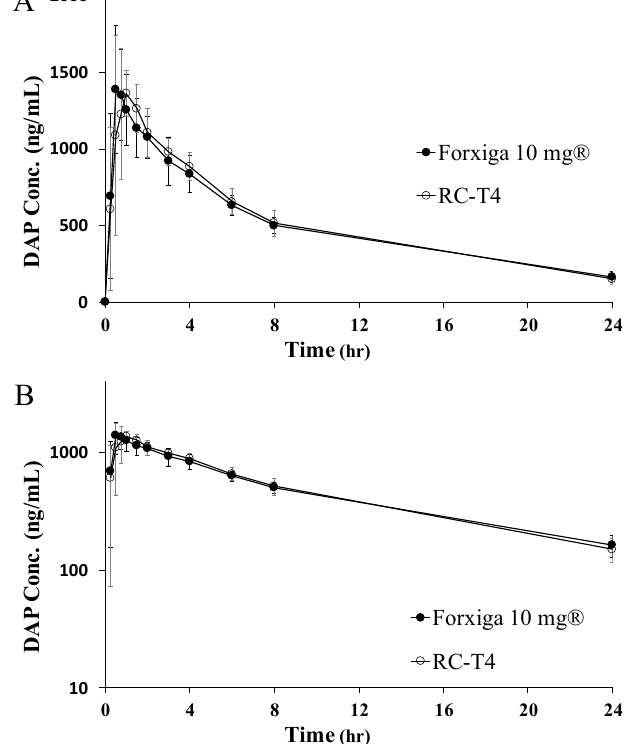
Figure 5. Average plasma concentration vs. time profiles of DAP after oral administration of Forxiga ® 10 mg ( ● ) and RC-T4 ( ○ ) in beagle dogs (( A ): linear scale, ( B ): semilog scale). Values are presented as the mean ± standard deviation ( n = 12). Table 4. PK parameters of dapagliflozin (DAP) after oral administration of Forxiga ® 10 mg and RC-T4 in beagle dogs.